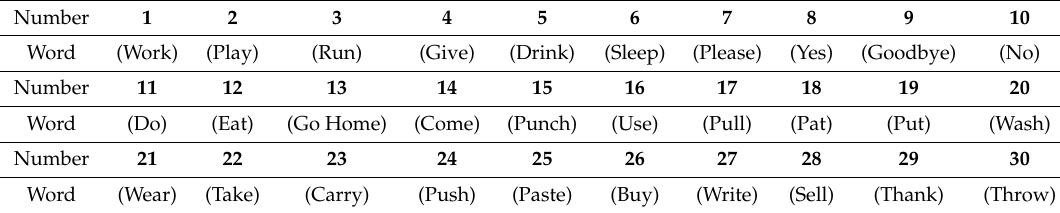
Table 1. Picture communication symbol (PCS) vocabulary list.